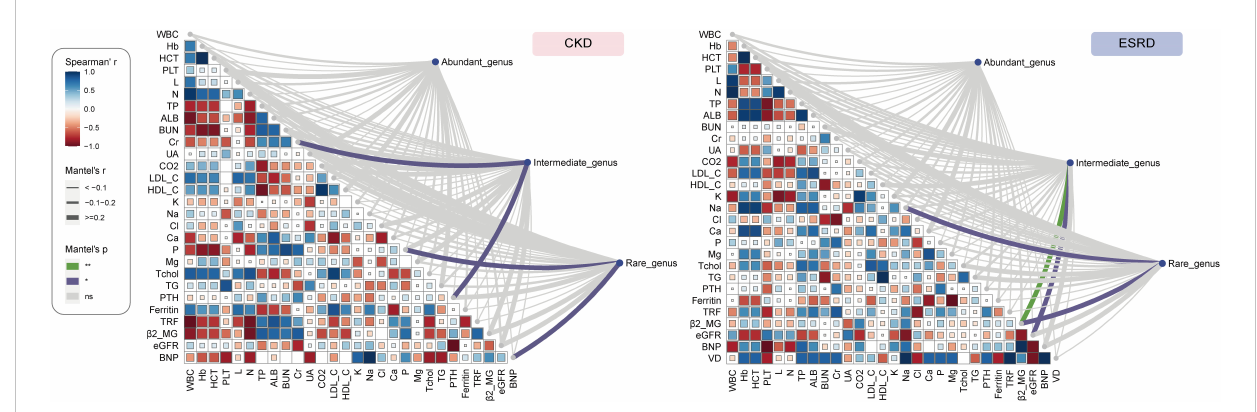
FIGURE 5 The Association of clinical indicators with genera abundance. Mantel test show the relationship between of all the abundant genus, intermediate genus, rare genus abundance and clinical indicators in CKD and ESRD